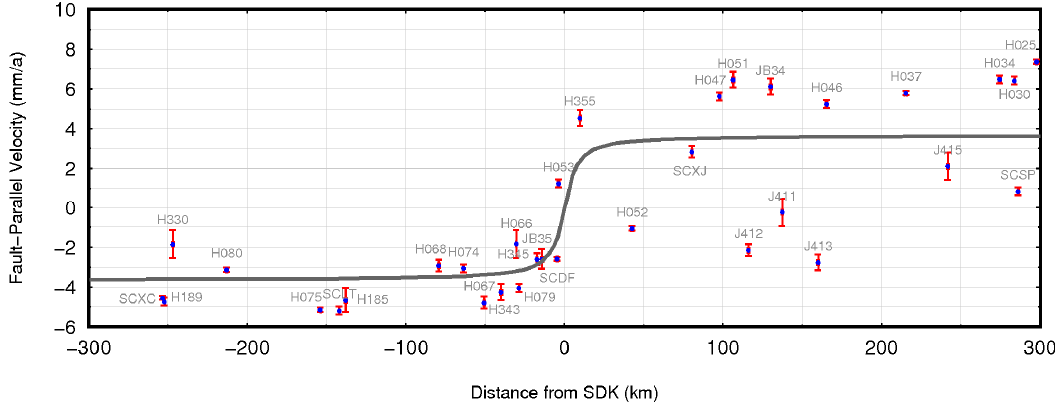
Figure 5. GPS horizontal fault-parallel velocities across the SDK. The gray line is the optimal fit curve. Blue points represent the fault-parallel velocities. The bars denote the σ error of the point measurements.